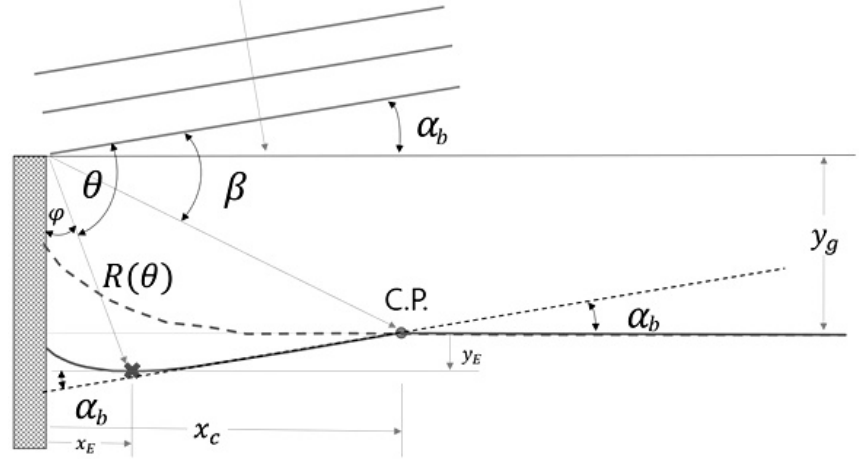
Figure 7. Application of the parabolic model based on the estimation of α b and downdrift control point (C. P.) and wave diffraction on the downdrift side of a groin.